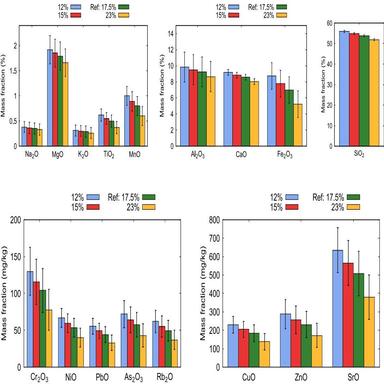
Variation of results for major and minor oxides of TR/0271 with different LOI values, Ref:.5% stands for the experimentally determined value.